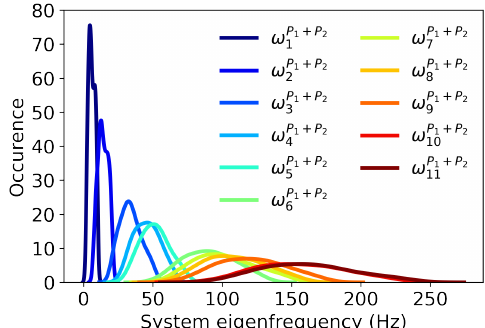
Figure 3. Histogram depicting the distribution of the first 11 eigenfrequencies of the system. For all 100 configurations, the first eigenfrequency ω P 1 + P 2 presents a narrow distribution between 5 and 1 8 Hz. For modes of higher order, curves cover a wider range, meaning that variations between configurations are huge.